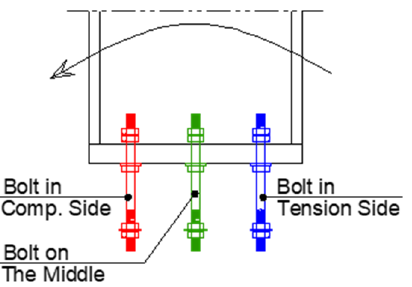
Figure 16. Anchor bolt arrangement according to moment direction.